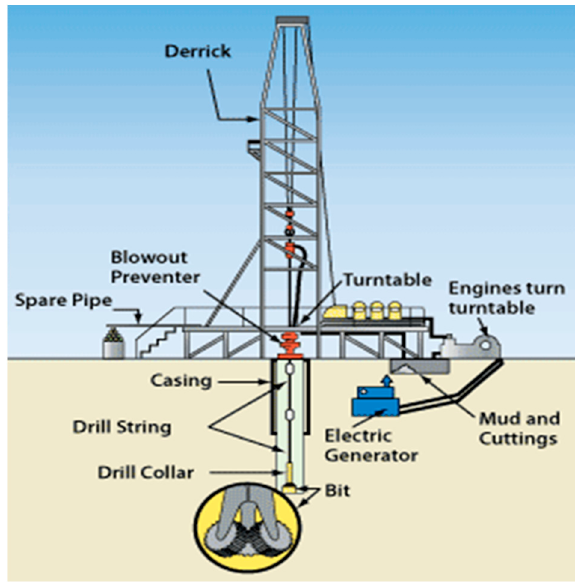
Figure 1. A general schema of typical rotary drilling system.